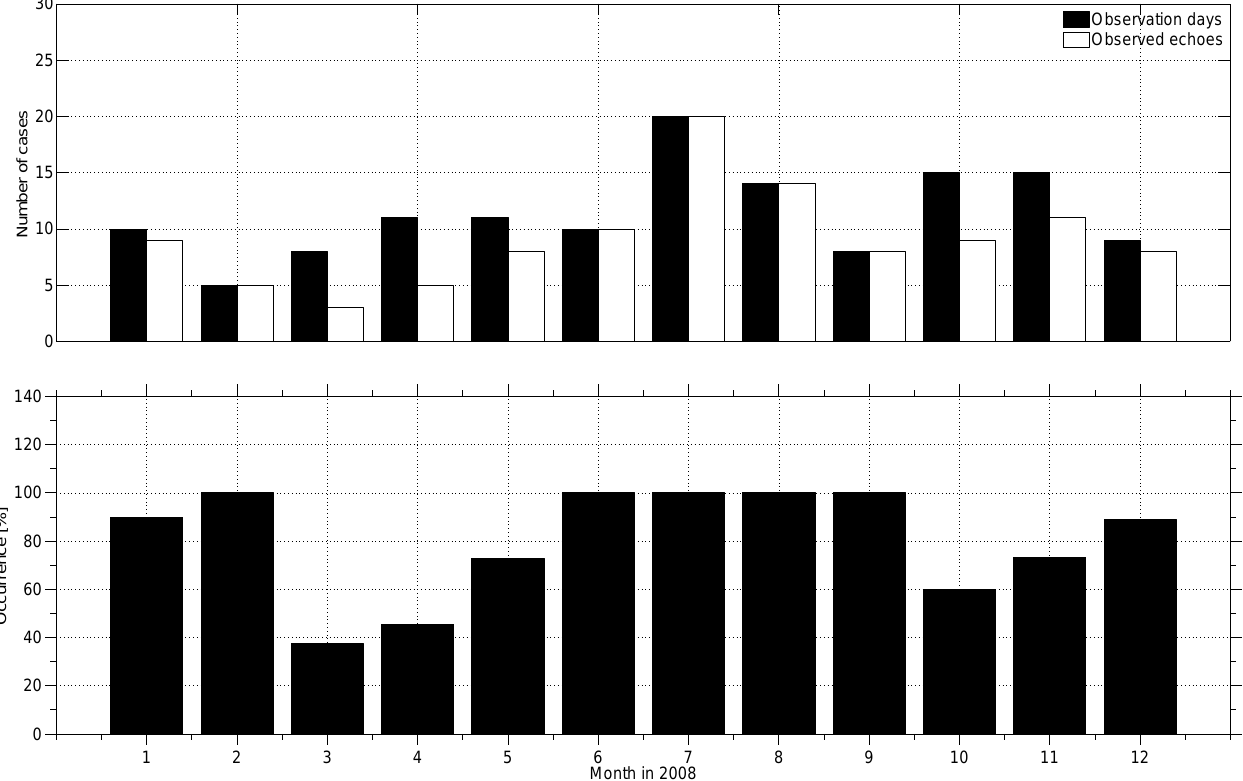
Fig. 2. Top panel shows the number of observation days for every month in 2008 and the number of days when 150-km echoes were observed in the RTI maps. The bottom panel shows the occurrence rate for each month computed using the information shown in the top panel.